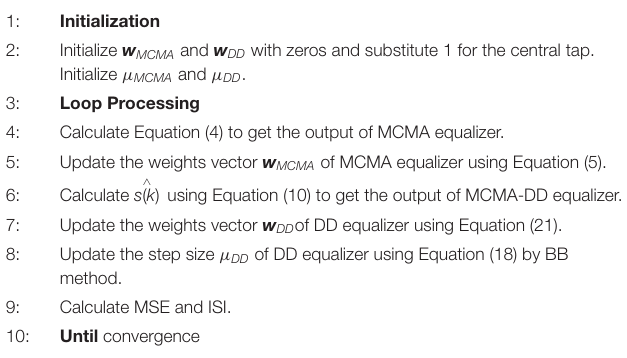
Algorithm 1 | Barzilai and Borwein method. Algorithm 2 | The proposed